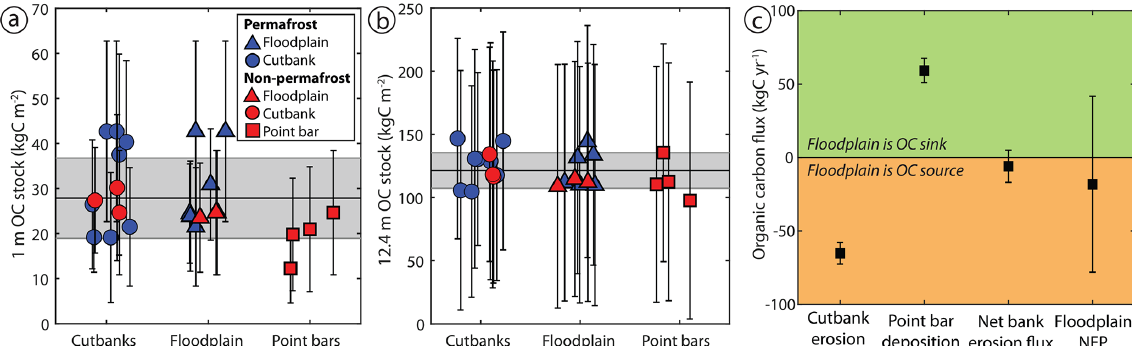
Figure 5. Carbon cycling due to river meandering. (a) Total organic carbon (OC) in each stratigraphic column integrated to 1m below surface, with unmeasured portions of the section assumed to be sand; horizontal lines indicate the mean and shaded regions 1SD for the complete dataset. (b) Total organic carbon in each stratigraphic column integrated to mean channel depth (12.4m) using the same assumptions and uncertainty. (c) The net OC flux due to channel migration is comparable to floodplain net ecological productivity (NEP), and both are zero within uncertainty. The net flux of OC into the river due to erosion of cutbanks and out of the river due to sediment deposition in point bars in the Koyukuk River is calculated as the mean OC stock for each landform (with ± 1SD OC stock uncertainty for that landform) multiplied by an average channel migration rate for a 1m downstream section of riverbank. The cutbank and point bar fluxes are differenced to calculate the net bank erosion flux. Floodplain NEP is calculated for a 10km wide, 1m downstream distance section of floodplain using previously reported regional NEP and uncertainties (Potter et al.,